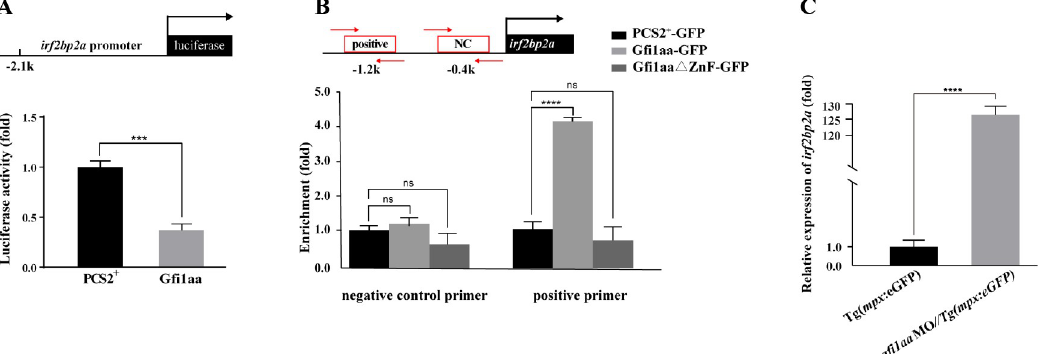
Fig 5. Irf2bp2a gene is repressed by Gfi1aa. (A) Luciferase reporter assay. Bars showed the relative luciferase activity on the zebrafish irf2bp2a promoter (-2.1 kb) (Student t test, N = 3. Error bars represent mean ± SEM. ��� P < 0.001). (B) CHIP-PCR analysis of irf2bp2a promoter in zebrafish embryos expressing GFP, Gfi1aa-GFP or Gfi1aa- Δ zinc finger-GFP using an anti-GFP antibody. The statistical significance was calculated by using one-way ANOVA. The asterisk indicates a statistical difference (N = 4. Error bars represent mean ± SEM. ns: not statistically significant, ���� P < 0.0001). (C) irf2bp2a relative expression level analyzed by quantitative PCR in GFP-positive cells sorted from control Tg(mpx : eGFP) embryos and gfi1aa MO injected Tg(mpx : eGFP) morphants at 2 dpf (Student t test, N = 5. Error bars represent mean ± SEM. ���� P <